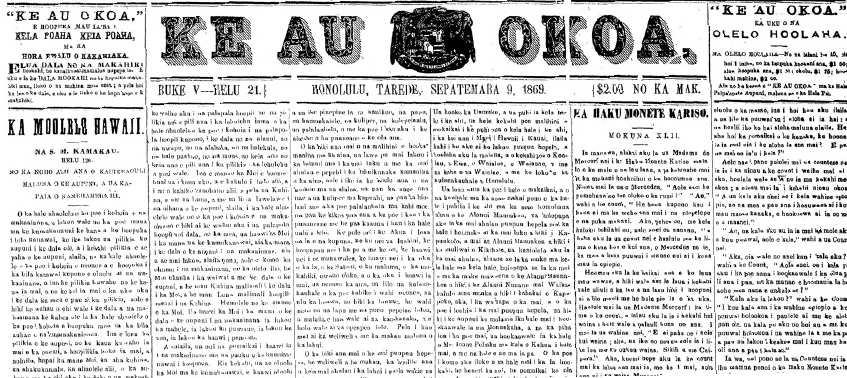
Fig. 1 Detail from Ke Au Okoa (Honolulu, HI), 9 September 1869. Image courtesy Papakilo